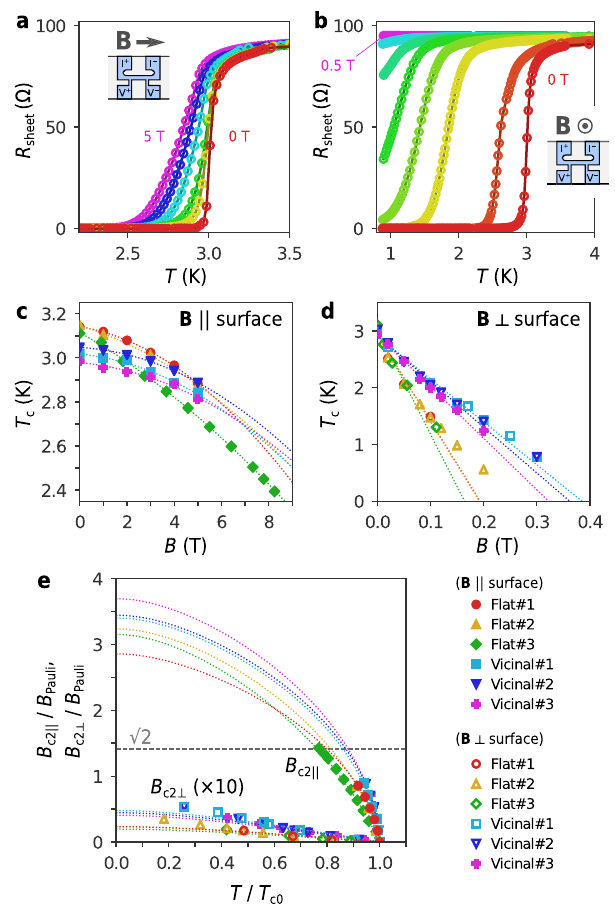
Fig. 5 Superconducting properties in in-plane and out-of-plane magnetic fi elds. a Resistance curves of Vicinal#1 in in-plane magnetic fi elds of B = 0, 1, 2, 3, 4 and 5 T. b Resistance curves of Vicinal#1 in out-of-plane magnetic fi elds of B = 0, 0.02, 0.1, 0.15, 0.2, 0.25, 0.3 and 0.5 T. The insets of ( a ) and ( b ) show the directions of the magnetic fi elds with respect to the samples. The samples were patterned in a shape suitable for four-terminal measurements, as represented by areas coloured in light blue. I + ( − ) and V + ( − ) are the current and voltage terminals, respectively. c Field dependence of T c in in-plane magnetic fi elds. d Field dependence of T c in out-of-plane magnetic fi elds. The dotted curves in ( c ) and ( d ) are the quadratic and linear functions fi tted to the data. e Comparison of B c2 ∥ and B B c2 ⊥ . For clarity, c2 ⊥ is scaled by a factor of 10. The dotted curves are the universal function Eq. (1) plotted with parameters determined from the fi tting analyses. The dashed horizontal line indicates the enhancement ffiffiffi p factor 2 for static locking effect of Rashba-type SOC. The relatively large variation in the fi tting curves for B c2 ∥ originates mainly from the angular error of the sample orientation denoted by θ e in the main